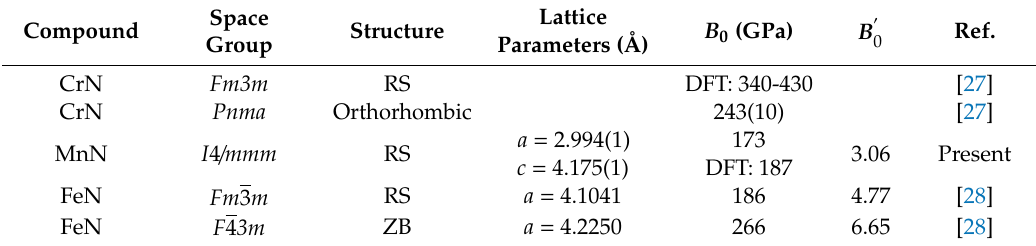
* RS represents rock-salt structure; ZB represents zinc blende